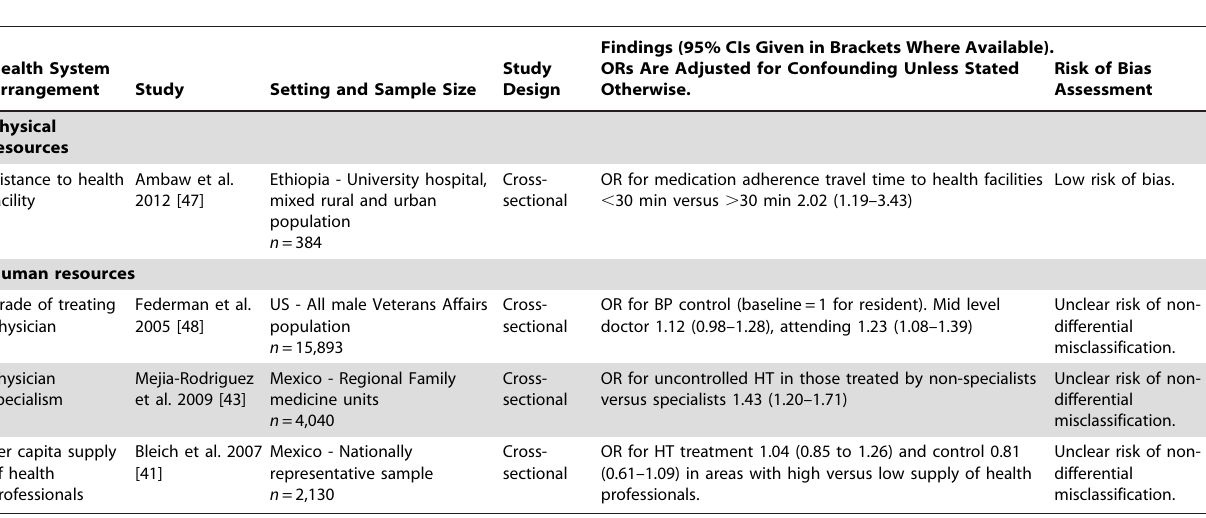
Table 2. Summary of findings of studies examining the associations of arrangements relating to human or physical resources with hypertension